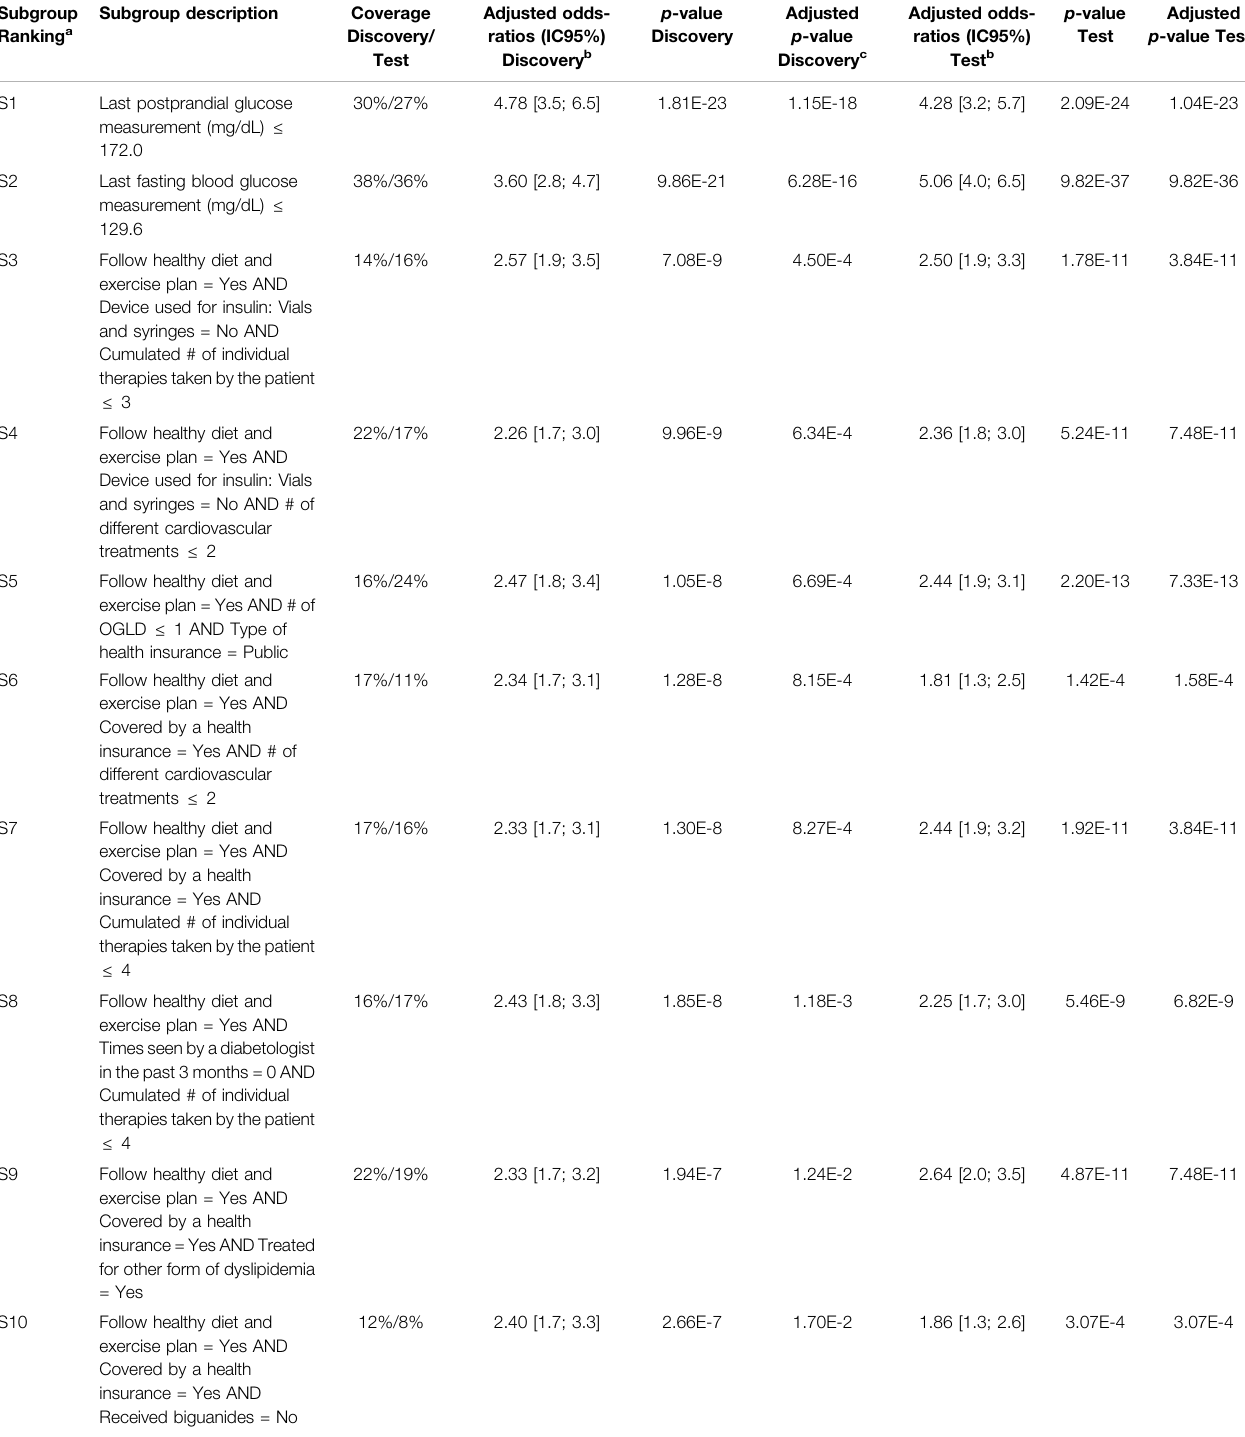
TABLE 1 | Q-Finder results on the detection of prognostic factors describing patients with better glycemic control. Subgroup Ranking